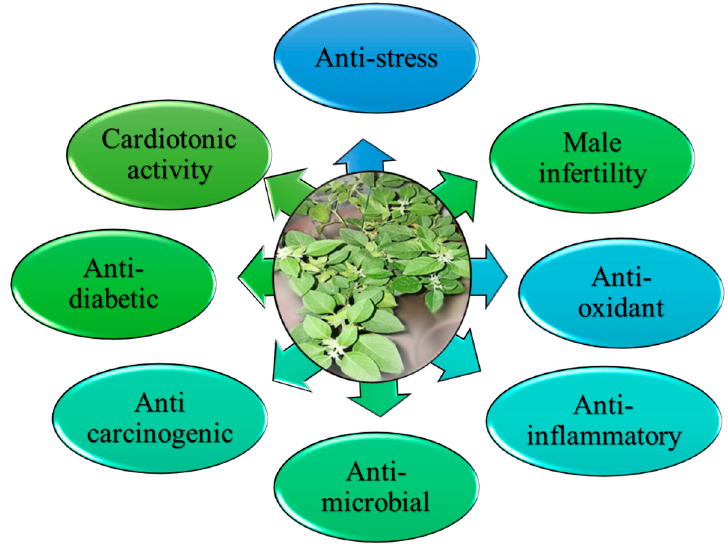
Figure 8. W. somnifera possesses various biological activities.